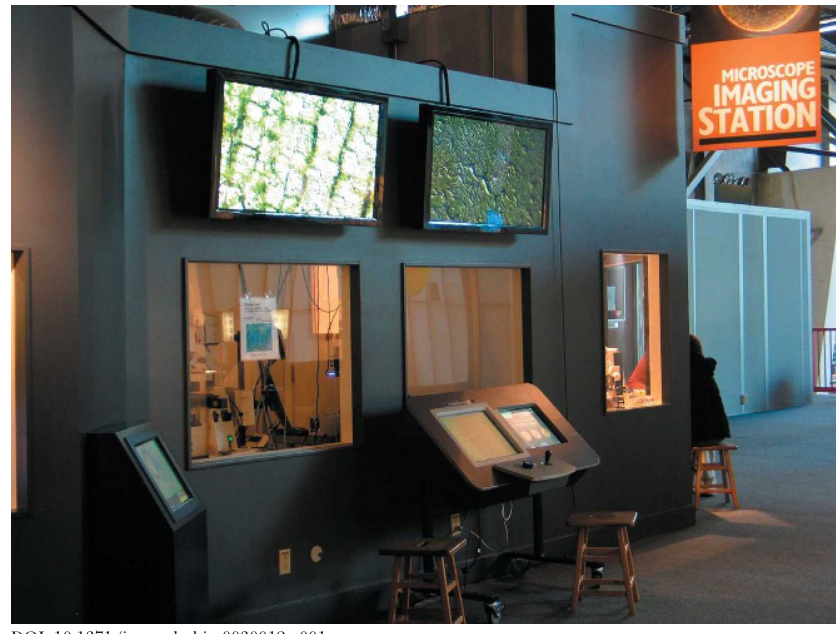
Figure 1. The Microscope Imaging Station Plasma screens, visitor microscope control consoles, and interactive media presentations provide visitors with access to live specimens and biomedical